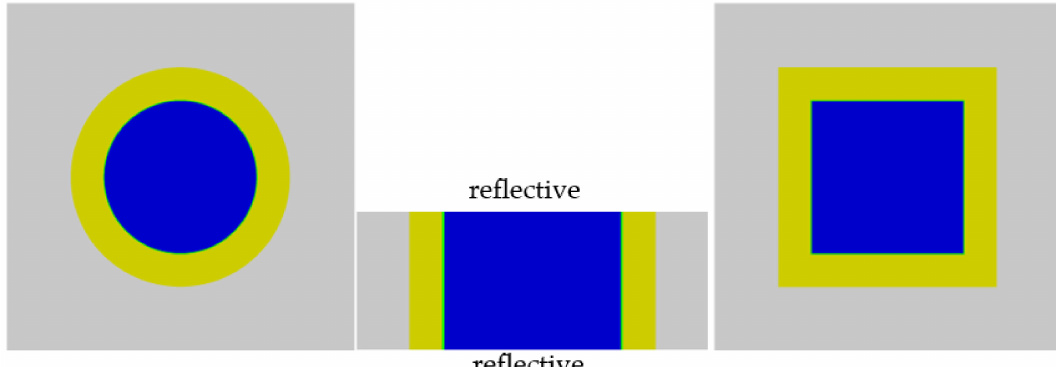
Figure 3. General 2D ( left and centre ) Monte Carlo model of the configuration ( left , top view x-y; centre, front view x-z) and 3D ( left and right ) Monte Carlo model of the configuration ( left , top view x-y; right, front view x-z) with a molten salt fuel core (blue), a stainless steel vessel (light green), the reflector (yellow), and a vacuum (grey) used for the validation of the results and the 3D